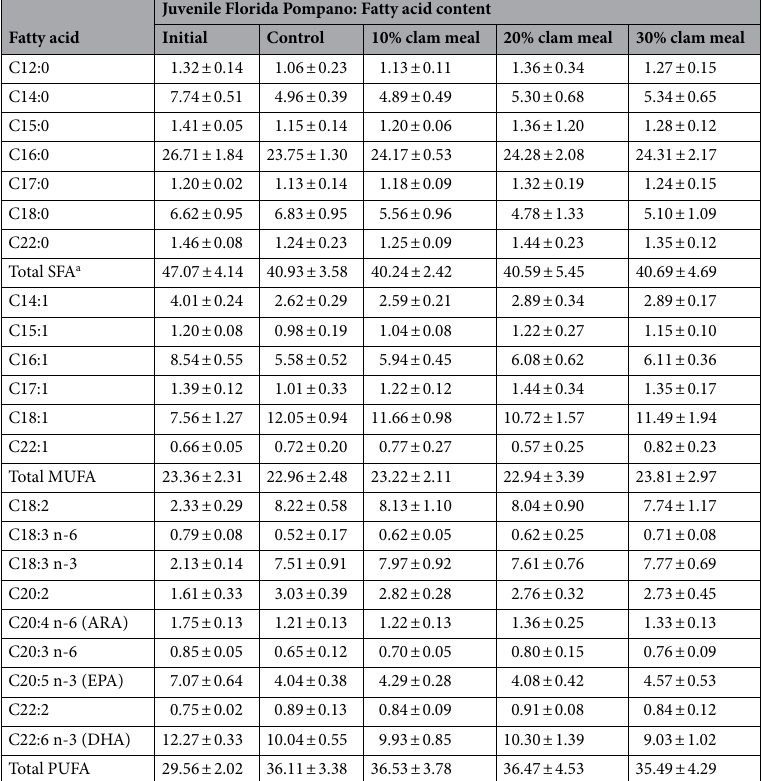
Table 6. Whole-body fatty acid compositions. Relative percentages of fatty acids (mean ± SD) in Florida pompano ( T. carolinus ) juveniles at the start of the experiment (referred to in the table as initial) and after 12-week feeding trial when they were fed a control diet, a 10% clam meal diet, a 20% clam meal diet, and a 30% clam meal diet. a Sum of saturated fatty acids (SFA) C13:0 and C20:0 for which the combined percentages are ≤ 0.5% of total fatty